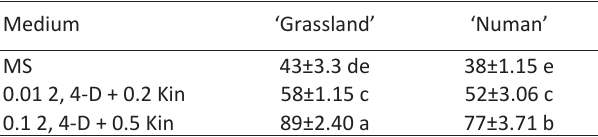
Table 2 - The regeneration percentage from meristem culture of two cultivars of perennial ryegrass on MS hormone- free and with PGRs media 0.05.Medium Values represent mean ± SE. Means with the same letter are not significantly different at p ≤